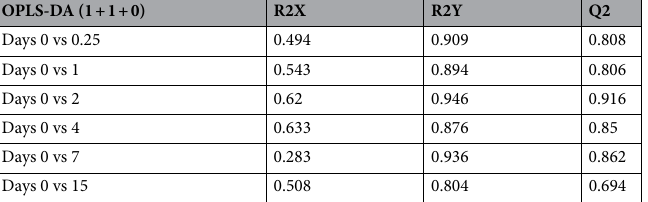
OPLS-DA (1 + 1 + 0) R2X R2Y Q2 Days 0 vs